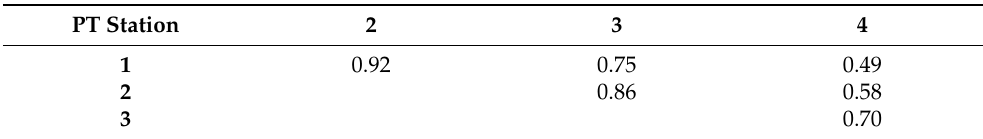
Table 8. Correlation of the displacement along the stream direction (Y-axis) of all the possible couples of points.